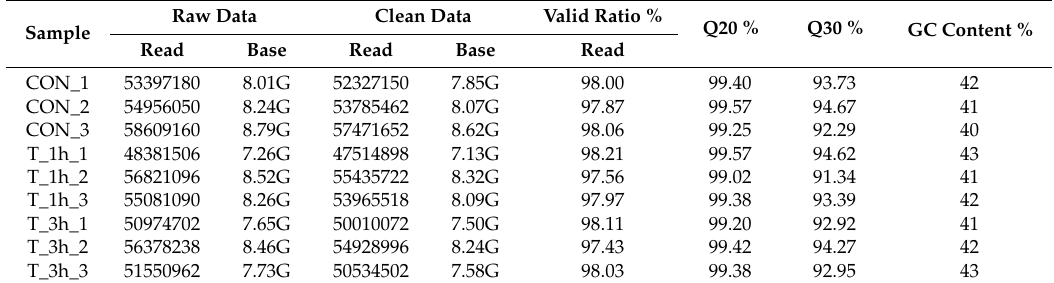
Table 1. Characteristics of the reads from nine different grade follicle libraries in A. japonicus body wall (AJBW).